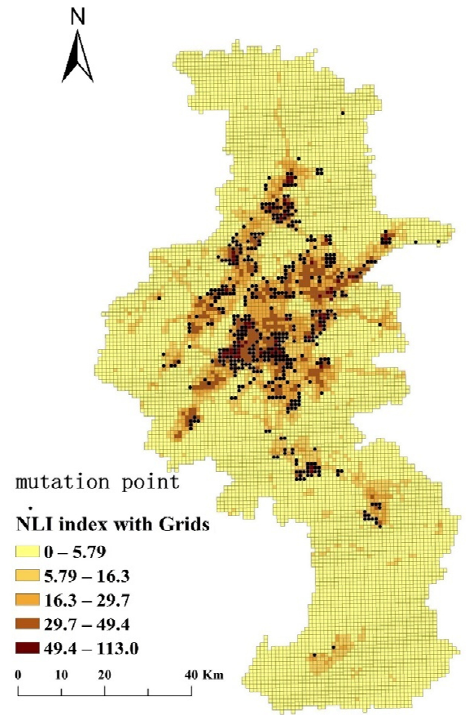
Figure 8. Mutation points mapping result.